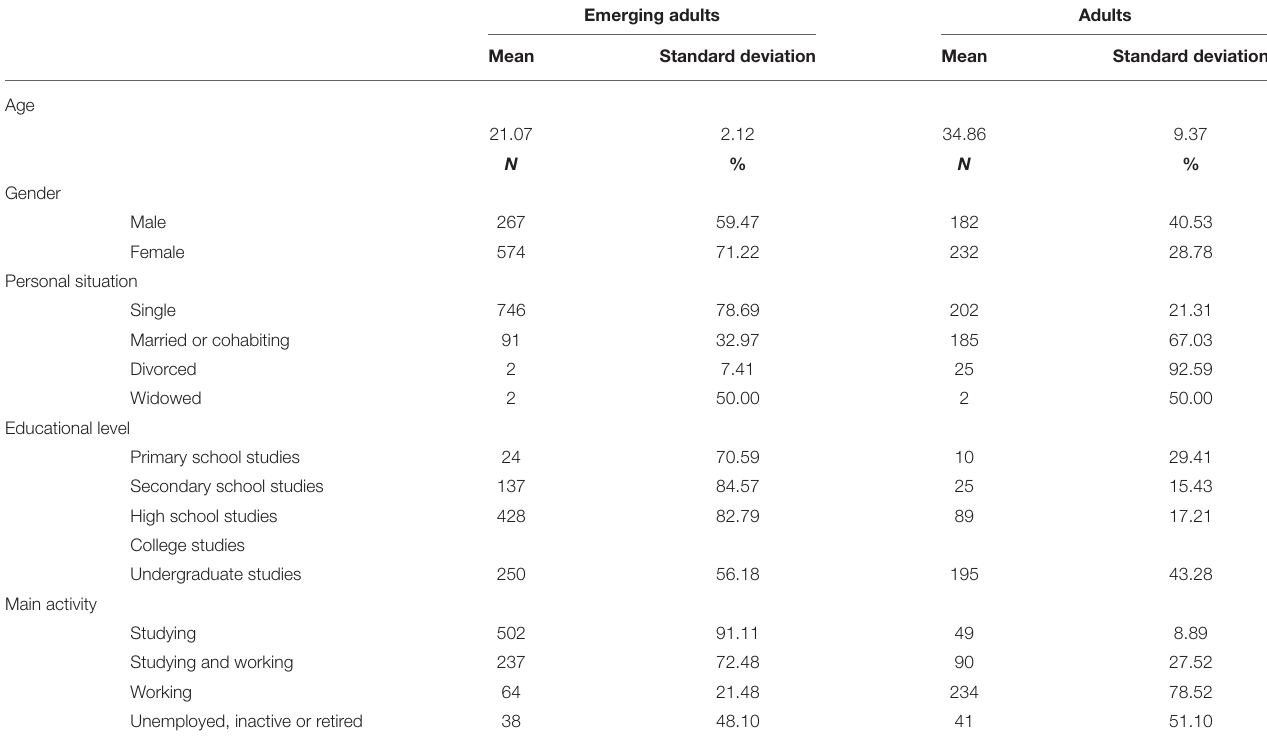
TABLE 1 | Sociodemographic characteristics for the “emerging adults” group and for the “adults”